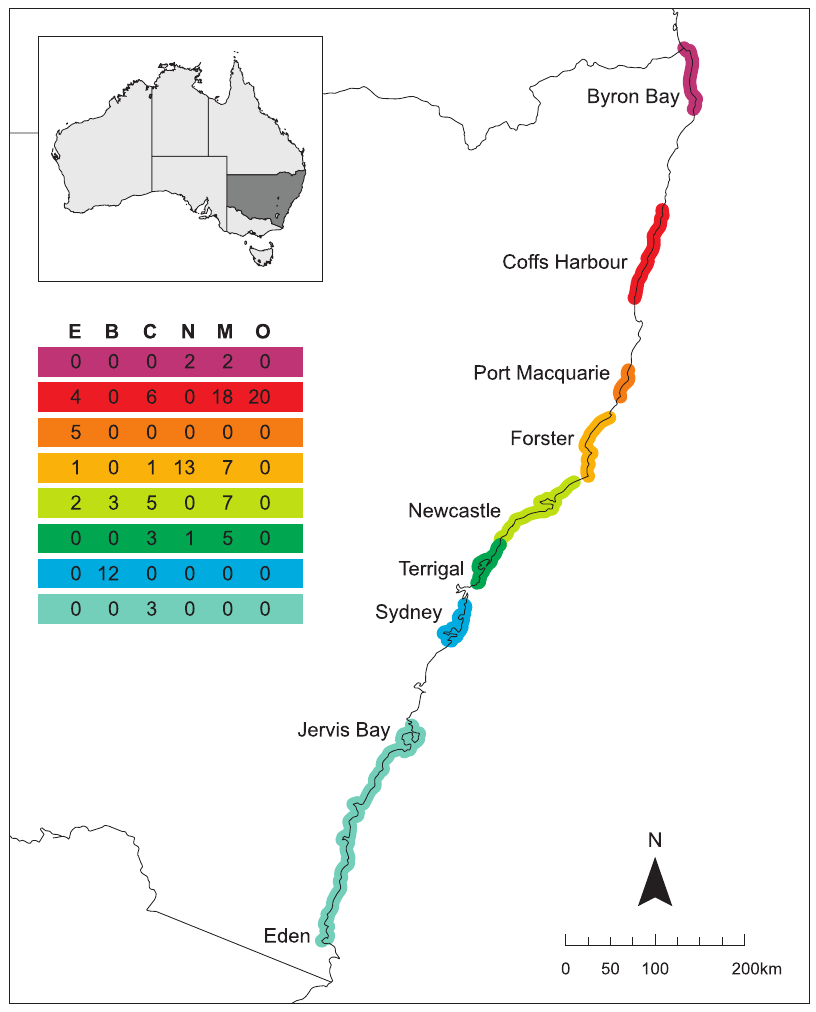
Figure 1. Map of the NSW coastline showing the regional coverage of the surveys. The table indicates the number of sites in each broad habitat category for each region: E= estuary; B= bay; C=coastal; N= nearshore reef; M= mid-shelf reef; O= offshore reef.